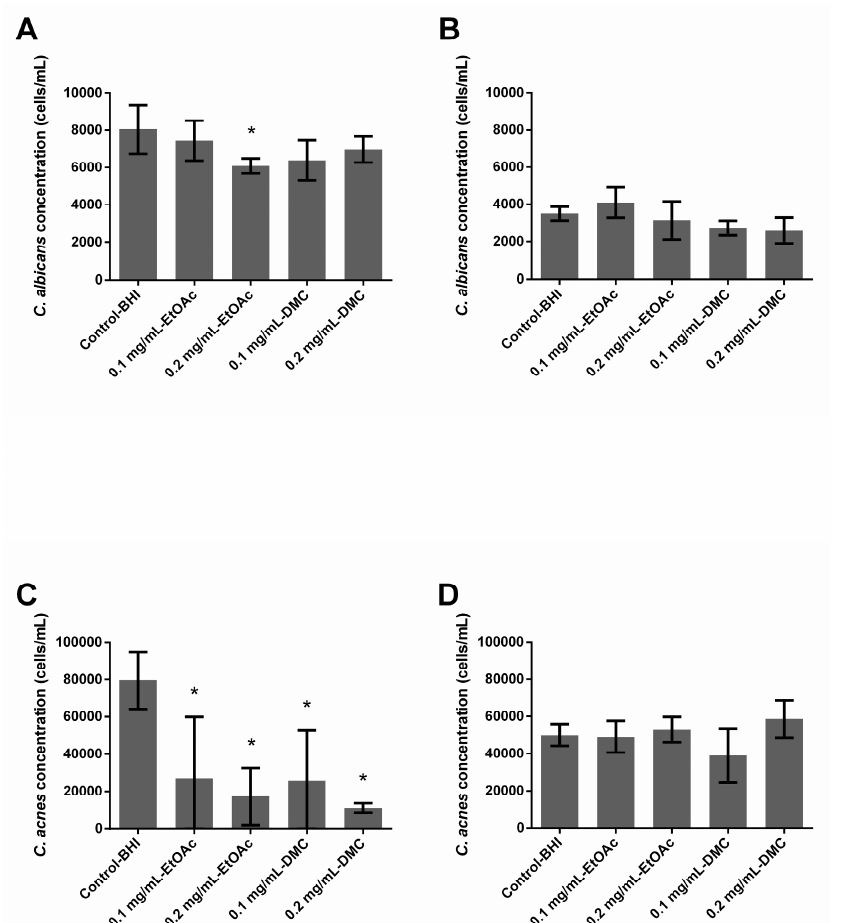
Figure 1. Ability of Arthrospira fusiformis extracts to prevent biofilm formation. Single-species biofilms ( C. albicans ) ( A ); C. albicans concentration obtained in dual-species biofilms ( C. albicans + C. acnes ) ( B ); single-species biofilms ( C. acnes ) ( C ); C. acnes concentration obtained in dual-species biofilms ( C. albicans + C. acnes ) ( D ). Results are expressed as mean ± SD. * p < 0.005: test condition vs. BHI-control (biofilms treated with BHI